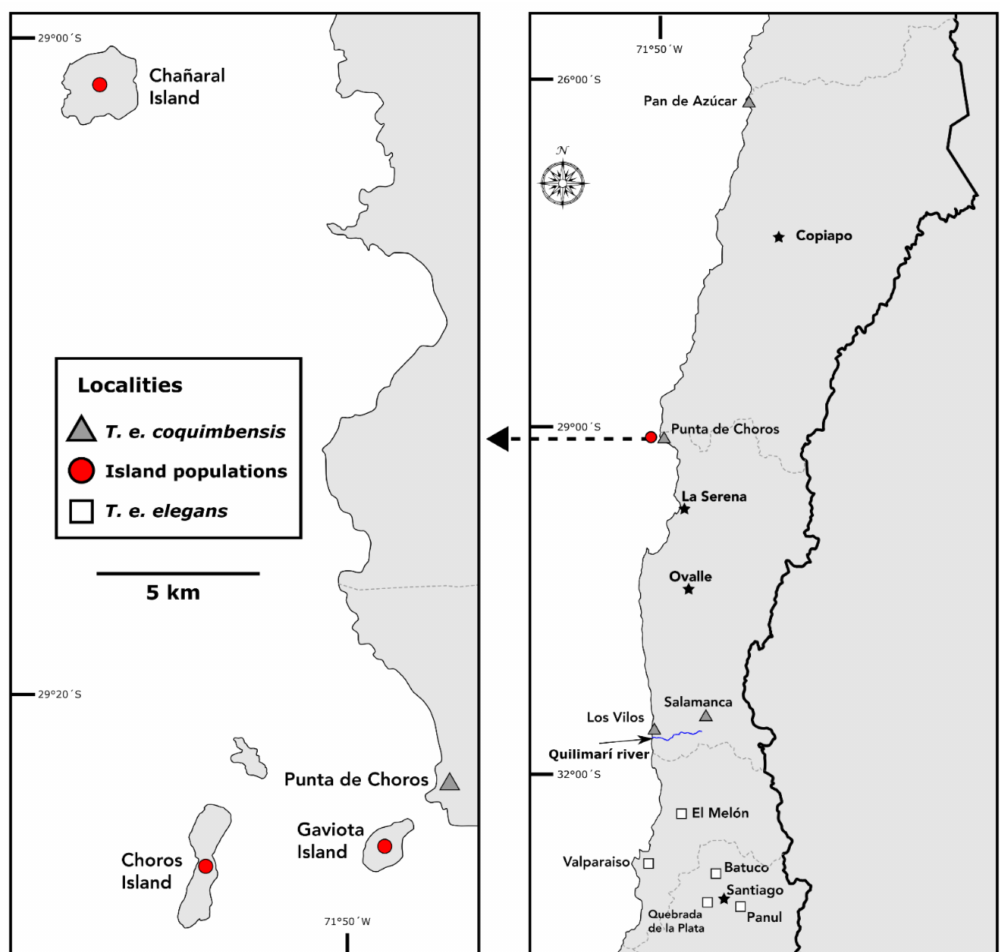
Figure 1. Distribution map of the samples used in this